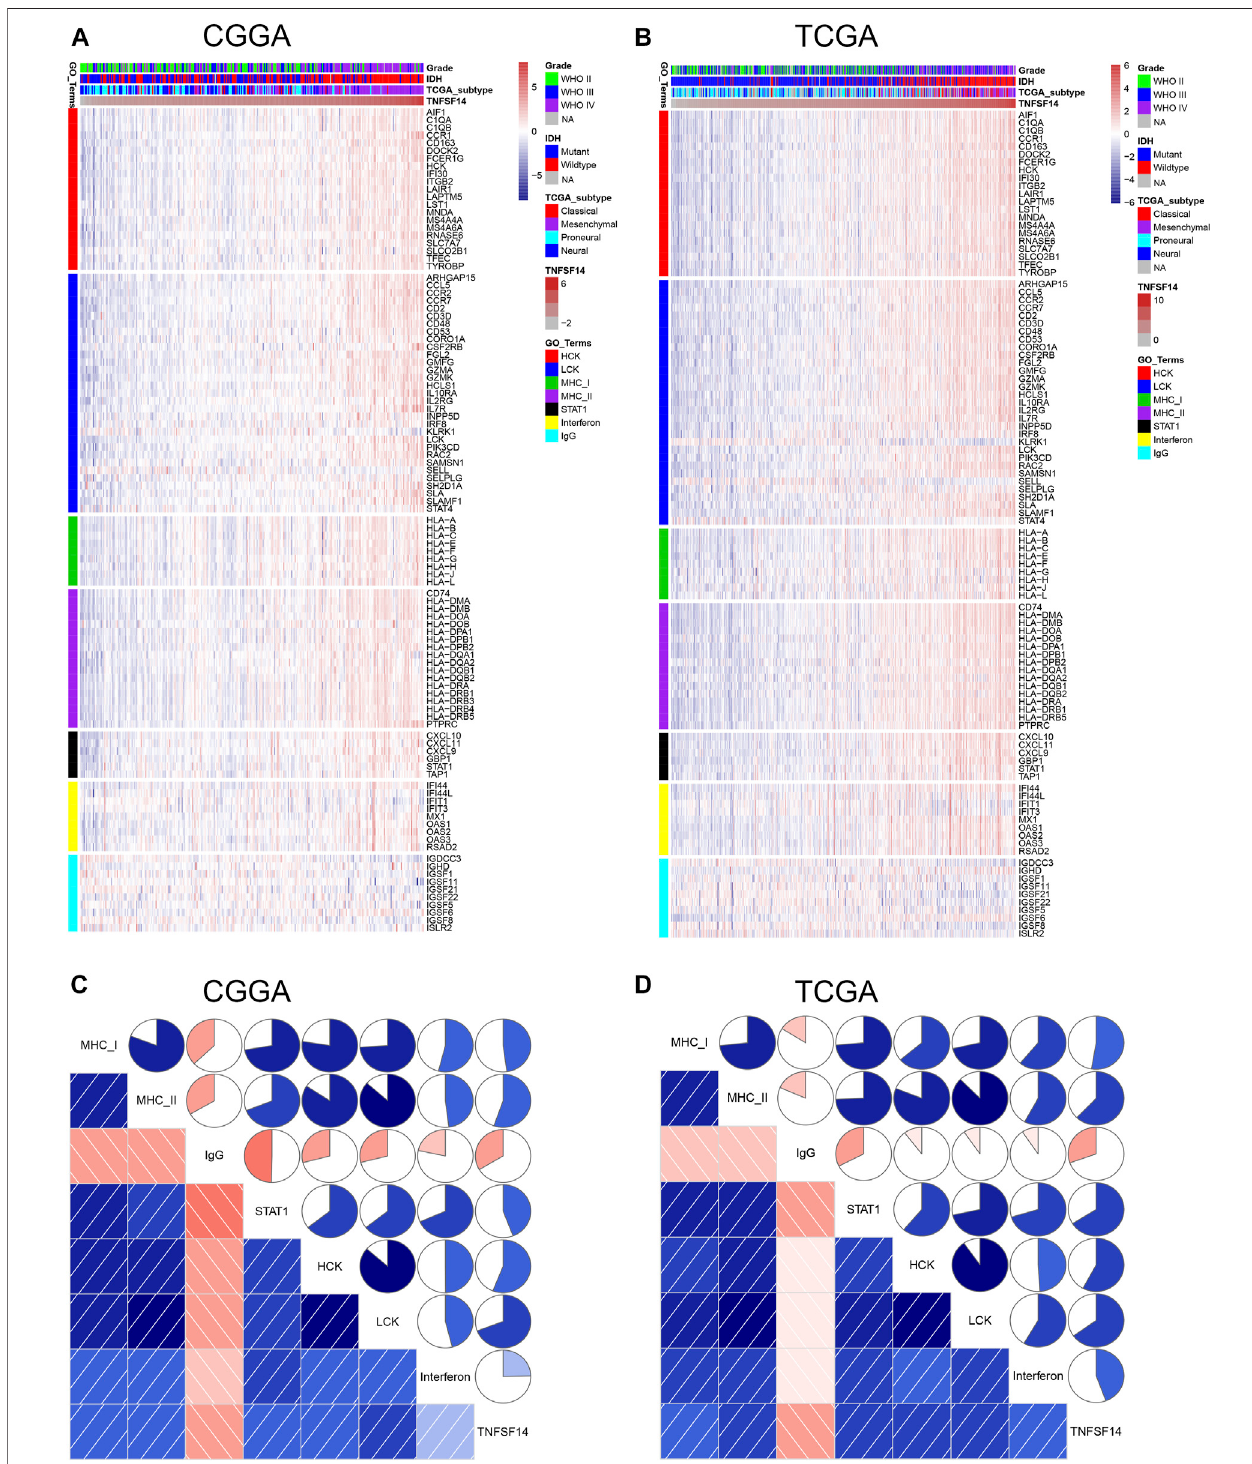
FIGURE 4 | Clusters (A , B) and gene set variation analysis (C , D) of LIGHT-related immune response.